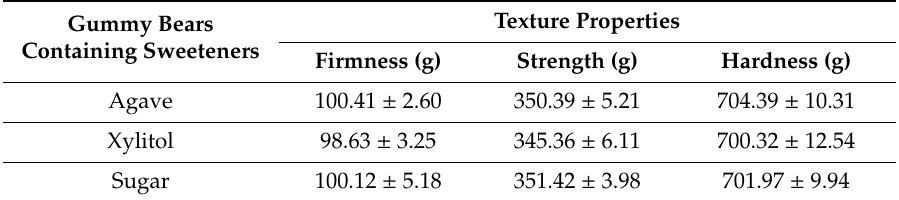
Table 1. The influence of added sweeteners on the textural properties of the gummy